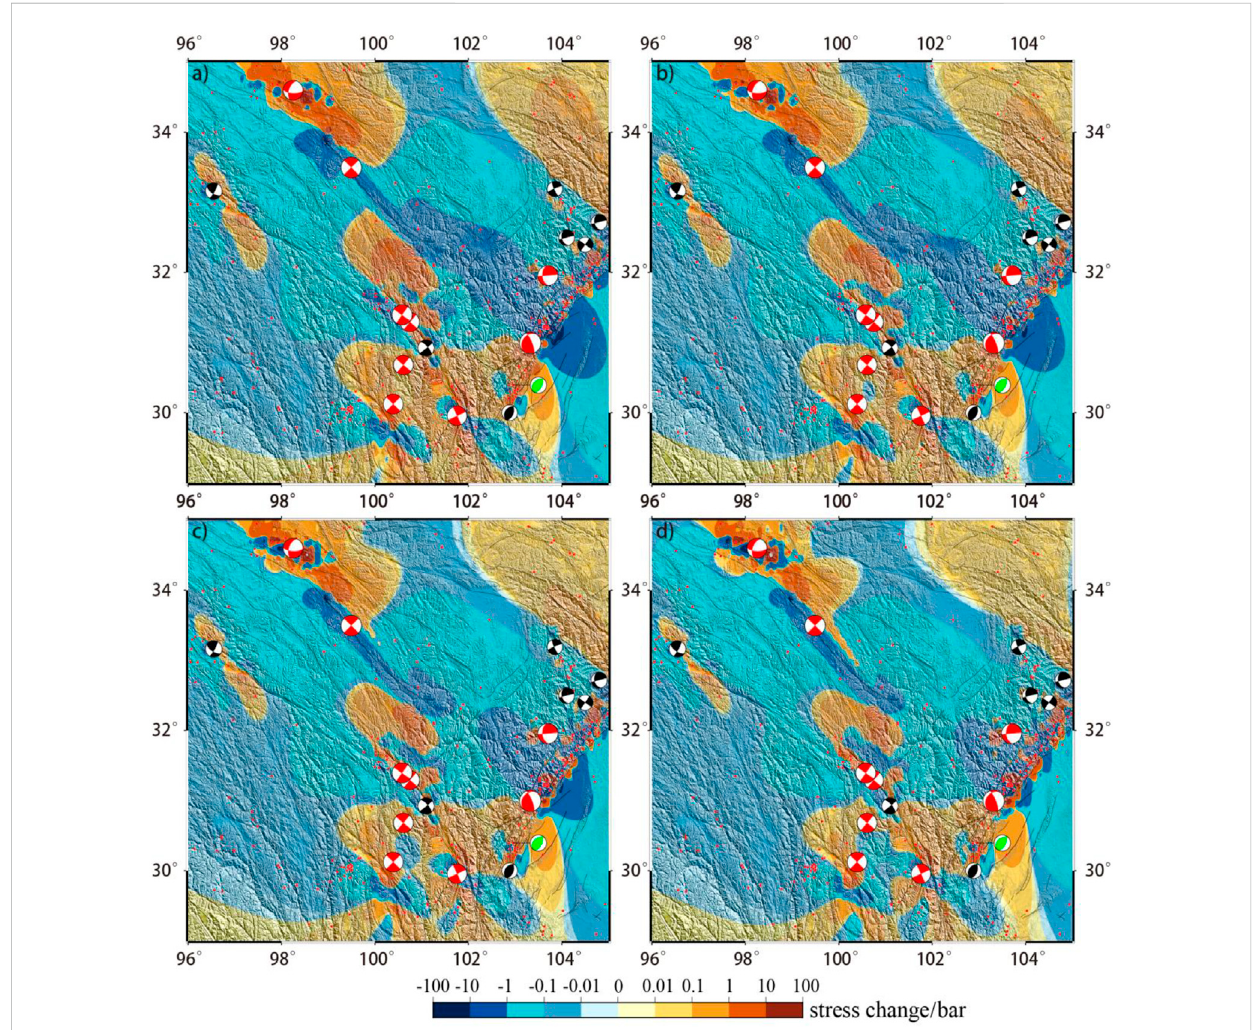
FIGURE 7 Impact of effective friction coef fi cients of 0.2, 0.4, 0.6, and 0.8 on the Coulomb stress change contour map of the Lushan earthquake in 2022 by historical earthquakes. (A – D) Contour maps of Coulomb stress change with effective friction coef fi cients of 0.2, 0.4, 0.6, and 0.8,